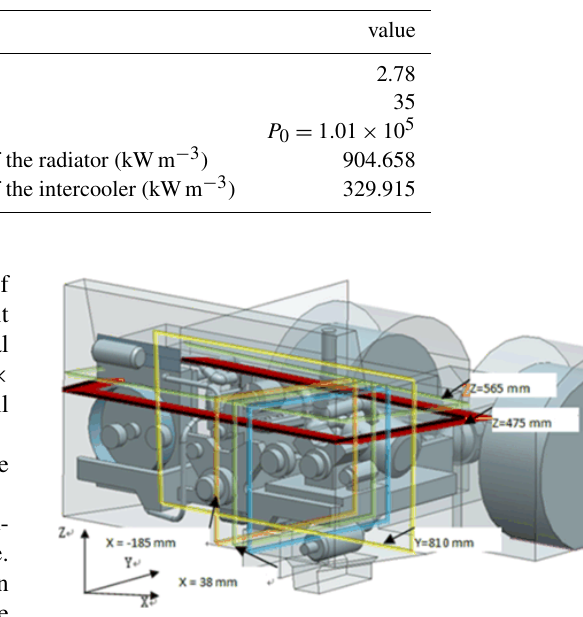
Figure 6. Typical structure and its key